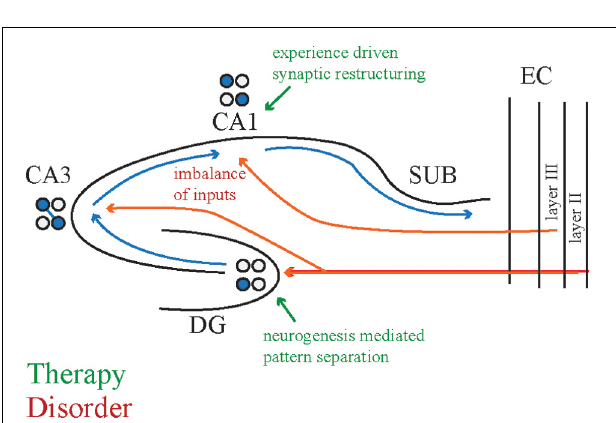
adolescence, iboNVHL animals are able to perform the task as well as saline controls. (C) Adolescence training had a positive impact on adult behavior in the active place avoidance task. iboNVHL animals that received cognitive training during adolescence performed as well as saline control animals when tested as adults. The animals that received noncognitive experience during adolescence remained impaired. Data are presented as average ± s.e.m.